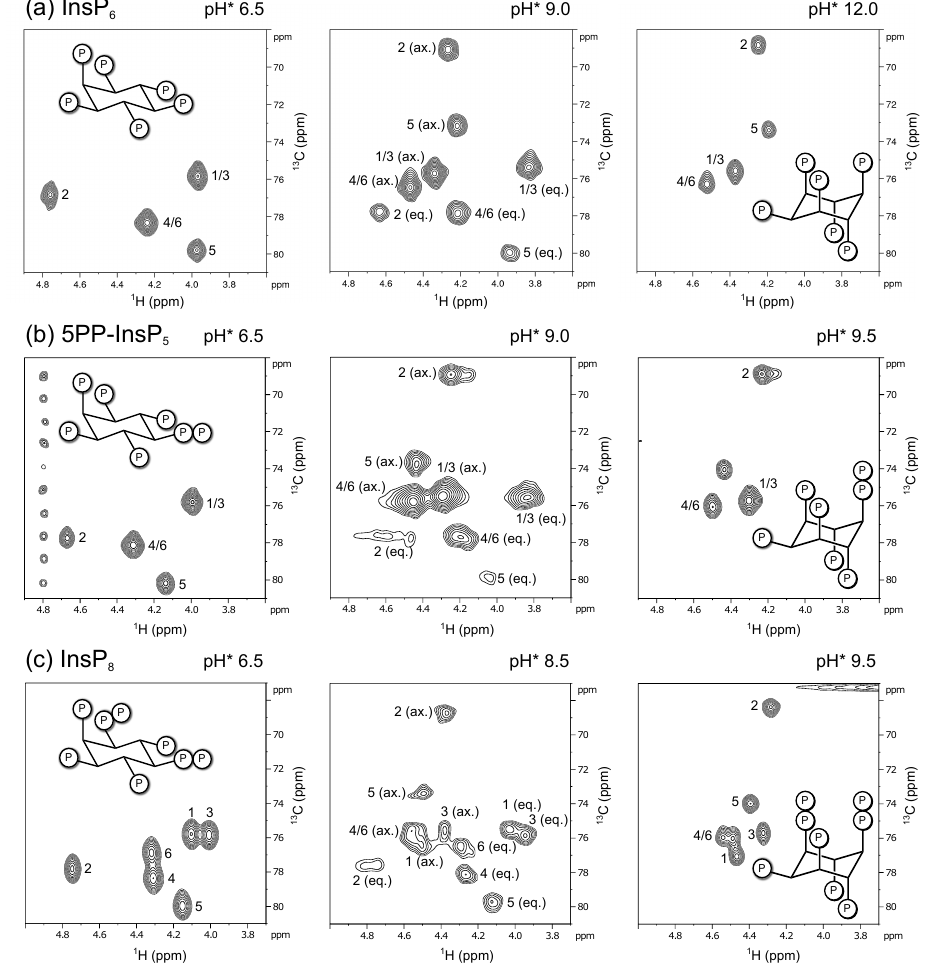
Figure 2. Representative 1 H, 13 C-HMQC-NMR spectra of 13 C-labeled ( a ) InsP 6 , ( b ) 5PP-InsP 5 and ( c ) InsP 8 in equatorial (eq.), axial (ax.) or mixed conformation, recorded at 4 ◦ C. Peaks correspond to inositol backbone protons and are labeled according to their position in the myo-inositol ring. Samples contained 50 µ M InsPs and 130 mM KCl, 10 mM NaCl in D 2 O. pH*-values measured in D 2 O can be converted to pH using the following formula: pH = 0.929 × pH* + 0.42 [35].